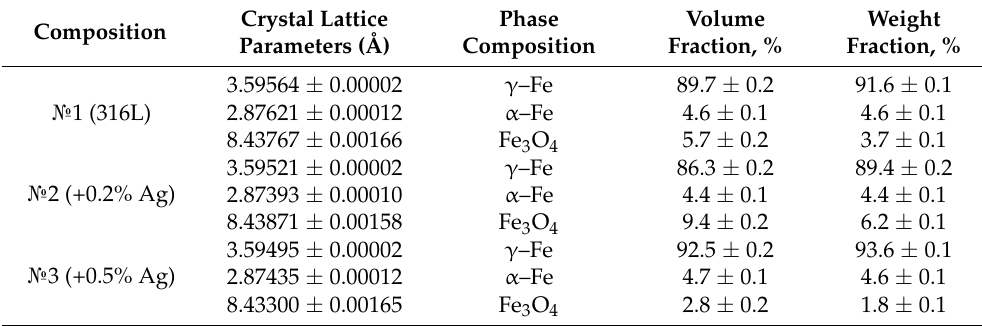
Table 4. Phase composition and parameters of the crystal lattice of